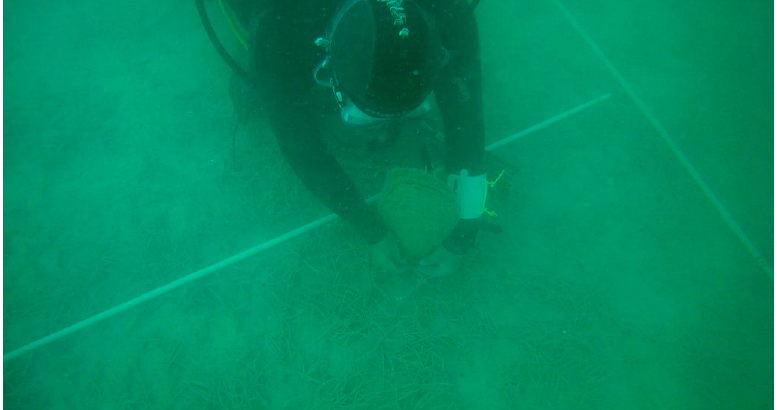
Figure 3. Labeling healthy individuals along the transect.